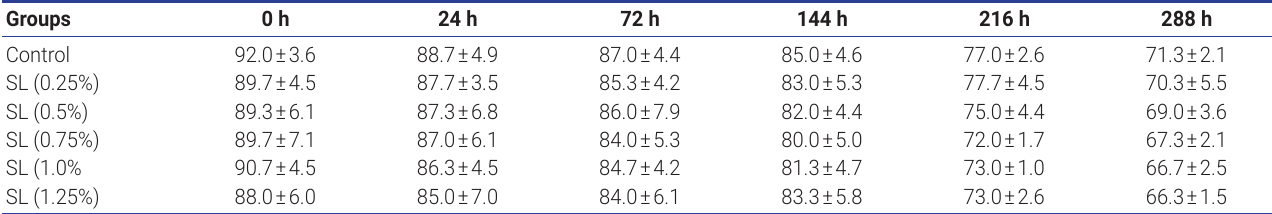
Table 2. Acrosome integrity sperm of Duolang rams’ sperm in diluents supplemented with different levels of soybean lecithin (mean±standard error of mean) Groups